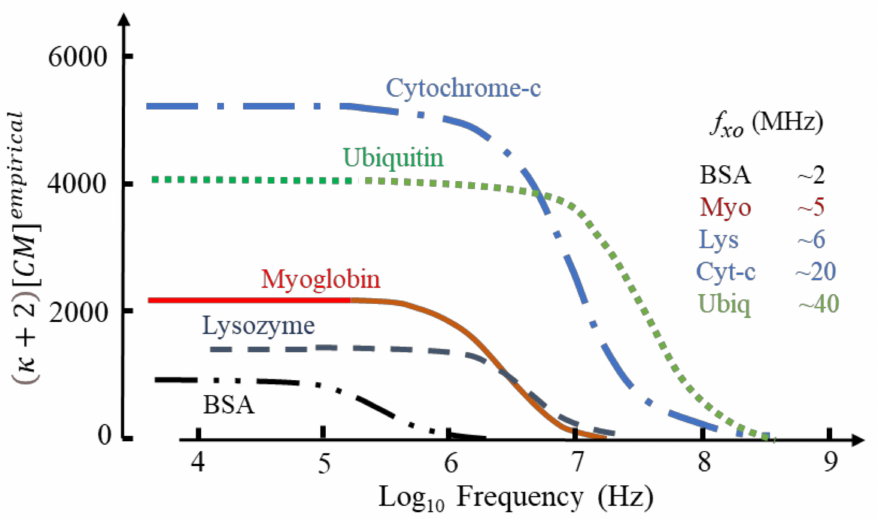
Figure 6. The frequency-dependence of the empirical factor ( κ + 2 )[ CM ] empirical derived from Equations (17) and (20) for selected proteins. The frequency, f xo , marking the transition between the dielectric increment and decrement of the β -dispersion is also